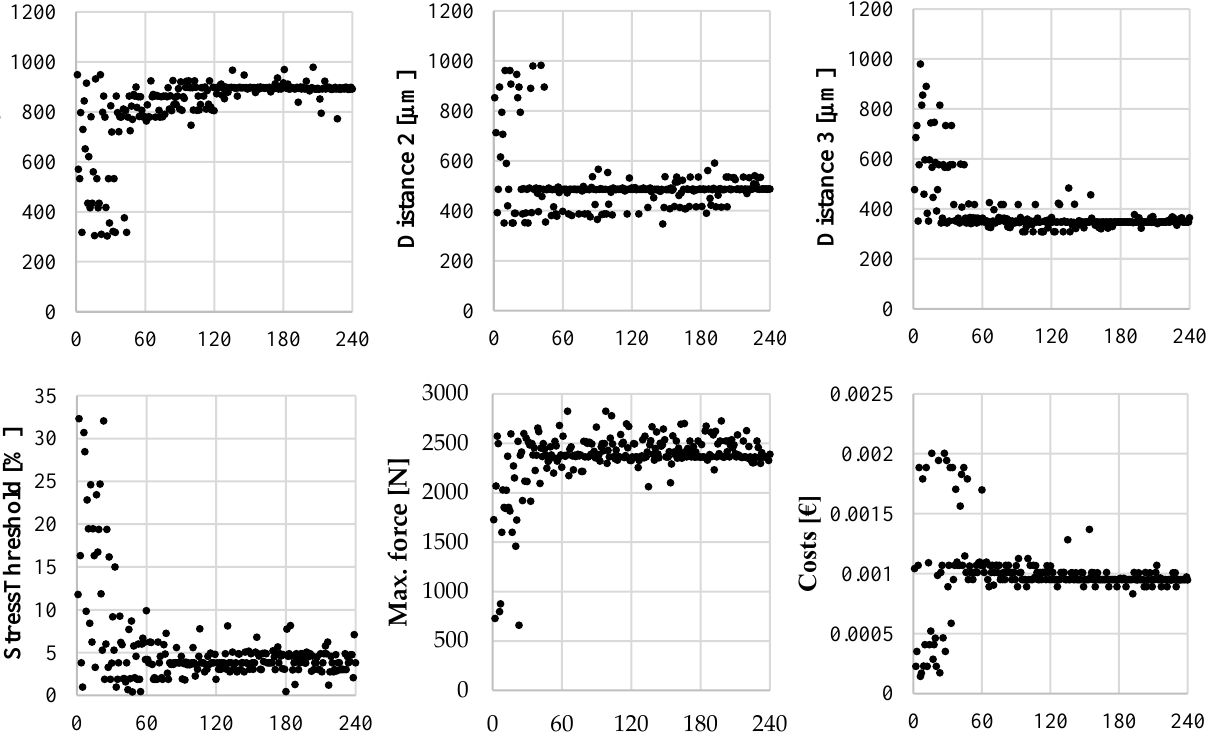
Figure 17. Optimization history of the benchmark (b).